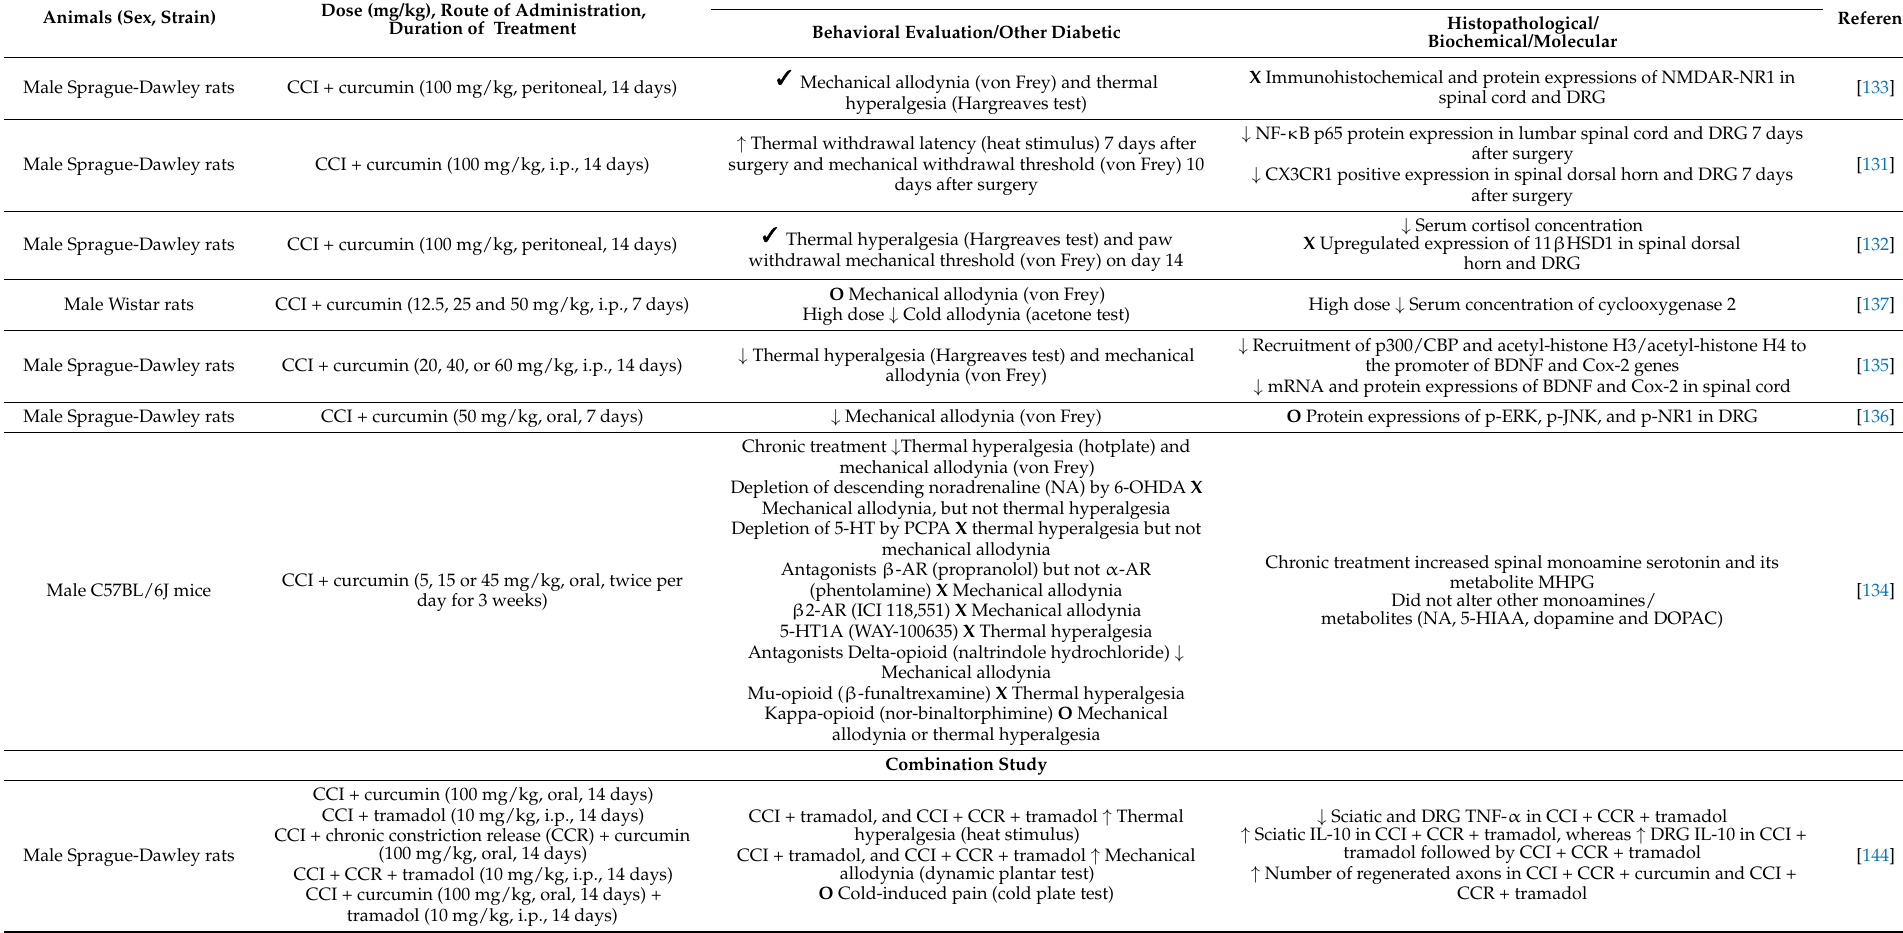
Table 3. Effects of curcumin on sciatic nerve chronic constriction injury (CCI).